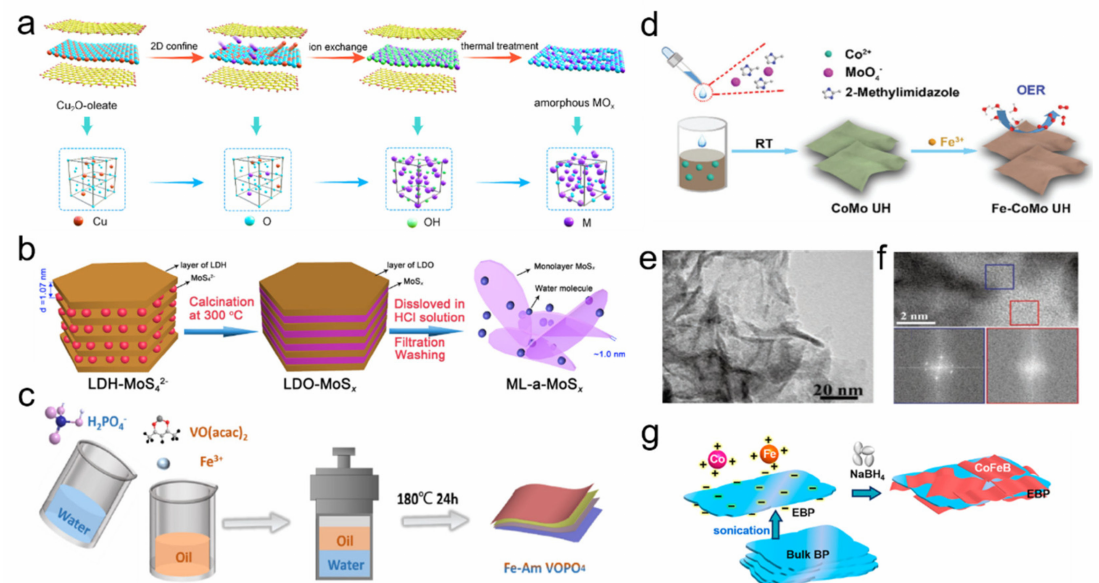
Figure 2. ( a ) Schematic illustration for synthesis of amorphous metal oxide ultrathin nanosheets. Reprinted with permission from Ref. [35]. Copyright American Chemical Society, 2020. ( b ) Schematic of the preparation process for amorphous MoS x monolayer nanosheets with abundant Mo defects. Reprinted with permission from Ref. [37]. Copyright Elsevier, 2020. ( c ) Schematic representation of the one-pot preparation processes of Fe-doped amorphous VOPO 4 . Reprinted with permission from Ref. [38]. Copyright Elsevier, 2021. ( d ) Schematic illustration of amorphous Fe-doped CoMo ultrathin hydroxide nanosheets. Reprinted with permission from Ref. [39]. Copyright Royal Society of Chemistry, 2021. ( e ) HRTEM image of CoV-Fe hydroxide nanosheets and ( f ) corresponding FFT patterns of selected regions marked by blue and red squares, respectively. Reprinted with permission from Ref. [40]. Copyright Wiley-VCH, 2020. ( g ) Schematic illustrations of the synthesis of EBP/CoFeB nanosheets. Reprinted with permission from Ref. [41]. Copyright American Chemical Society,